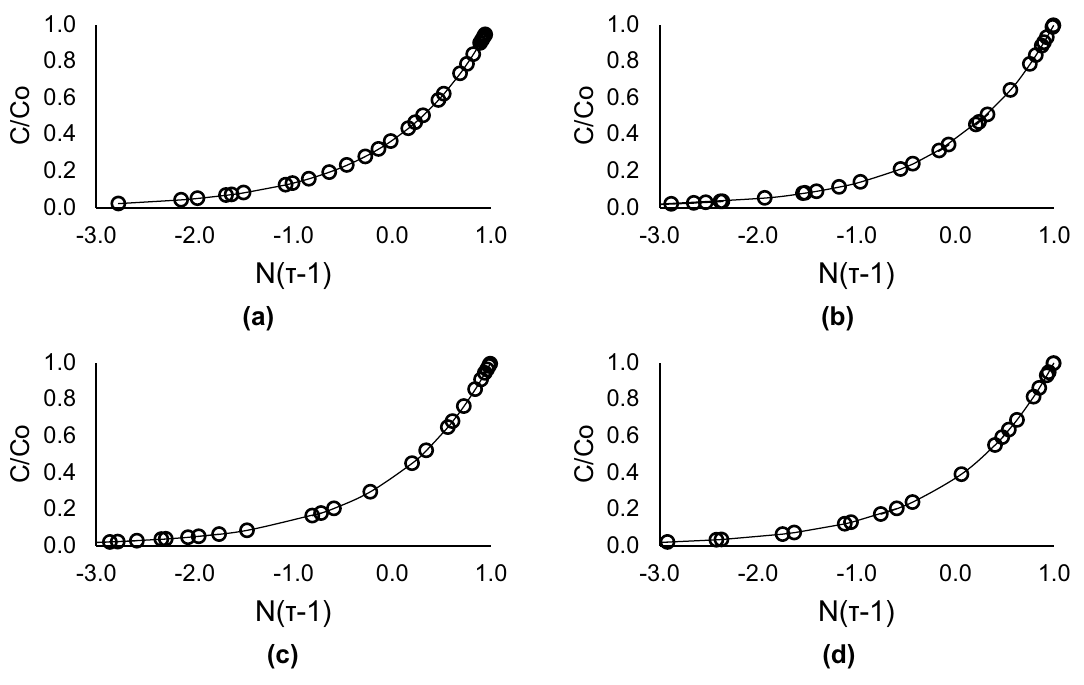
Fig. 3 Breakthrough curves for irreversible adsorption of Cr (VI) and Ni (II) natural sugar cane bagasse at different experimental conditions: a Co (Cr) = 10 mg/L and m = 1.5 g; b Co (Cr) = 15 mg/L and m = 1.5 g; c Co (Ni) = 15 mg/L and m = 1.5 g; d Co (Ni) = 25 mg/L and m = 1.5